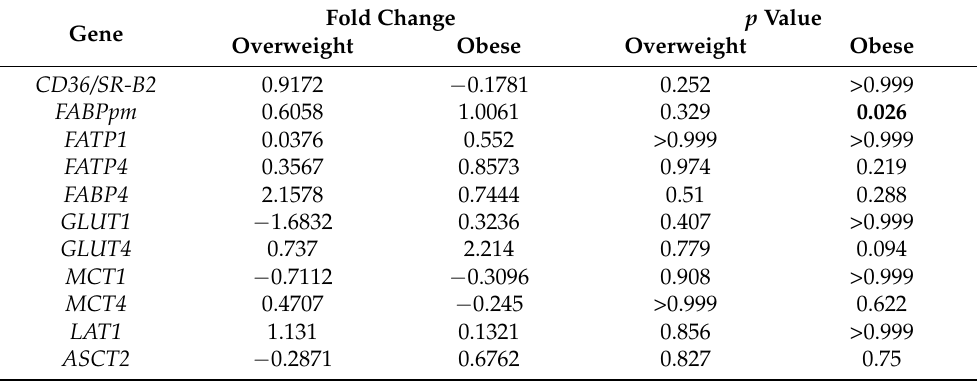
Table 3. Log2-fold changes in gene expression in ovarian cancer tissue obtained from overweight (n = 9) or obese patients (n = 10) compared to lean individuals (n = 8). Fold Change p Value Gene Overweight Obese Overweight Obese CD36/SR-B2 0.9172